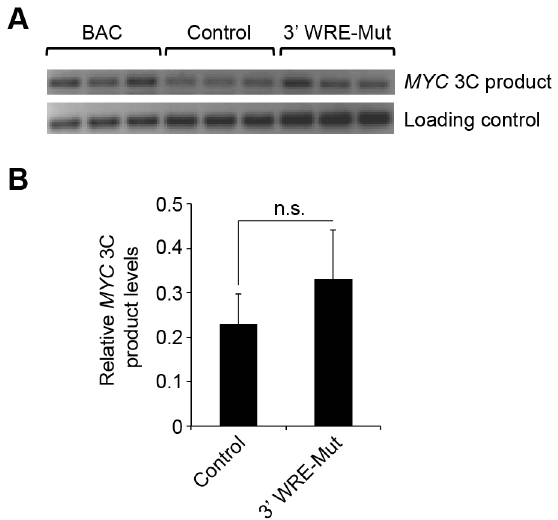
Figure 3. The MYC 5 ′ 3 ′ chromatin loop is maintained in 3 ′ WRE ‐ Mut cells. ( A ) PCR products generated from chromosome conformation capture (3C) analysis conducted in control or 3 ′ WRE ‐ Mut cells. A bacterial artificial chromosome (BAC) harboring the MYC locus was used as a control for 3C. An internal region of MYC that is retained in the looped conformation served as a loading control; ( B ) quantification of 3C products. Band intensities were measured from 3 biological replicates, each with 3 technical replicates. n.s., not significant. Error bars are ±SEM.